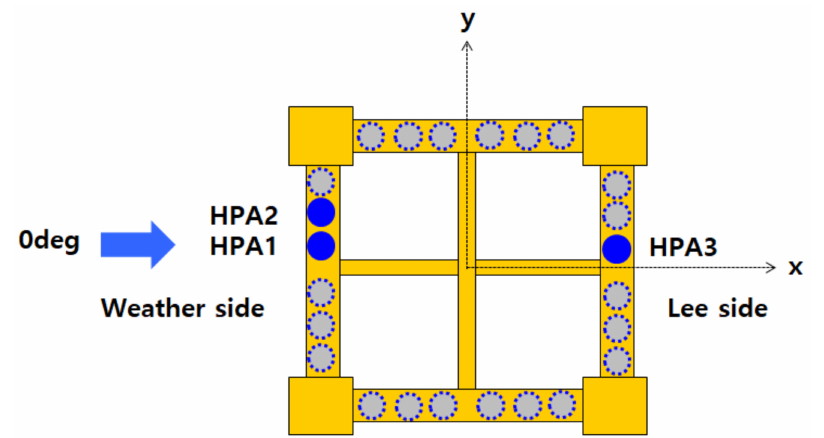
Figure 11. Location of HPAs for measurement of